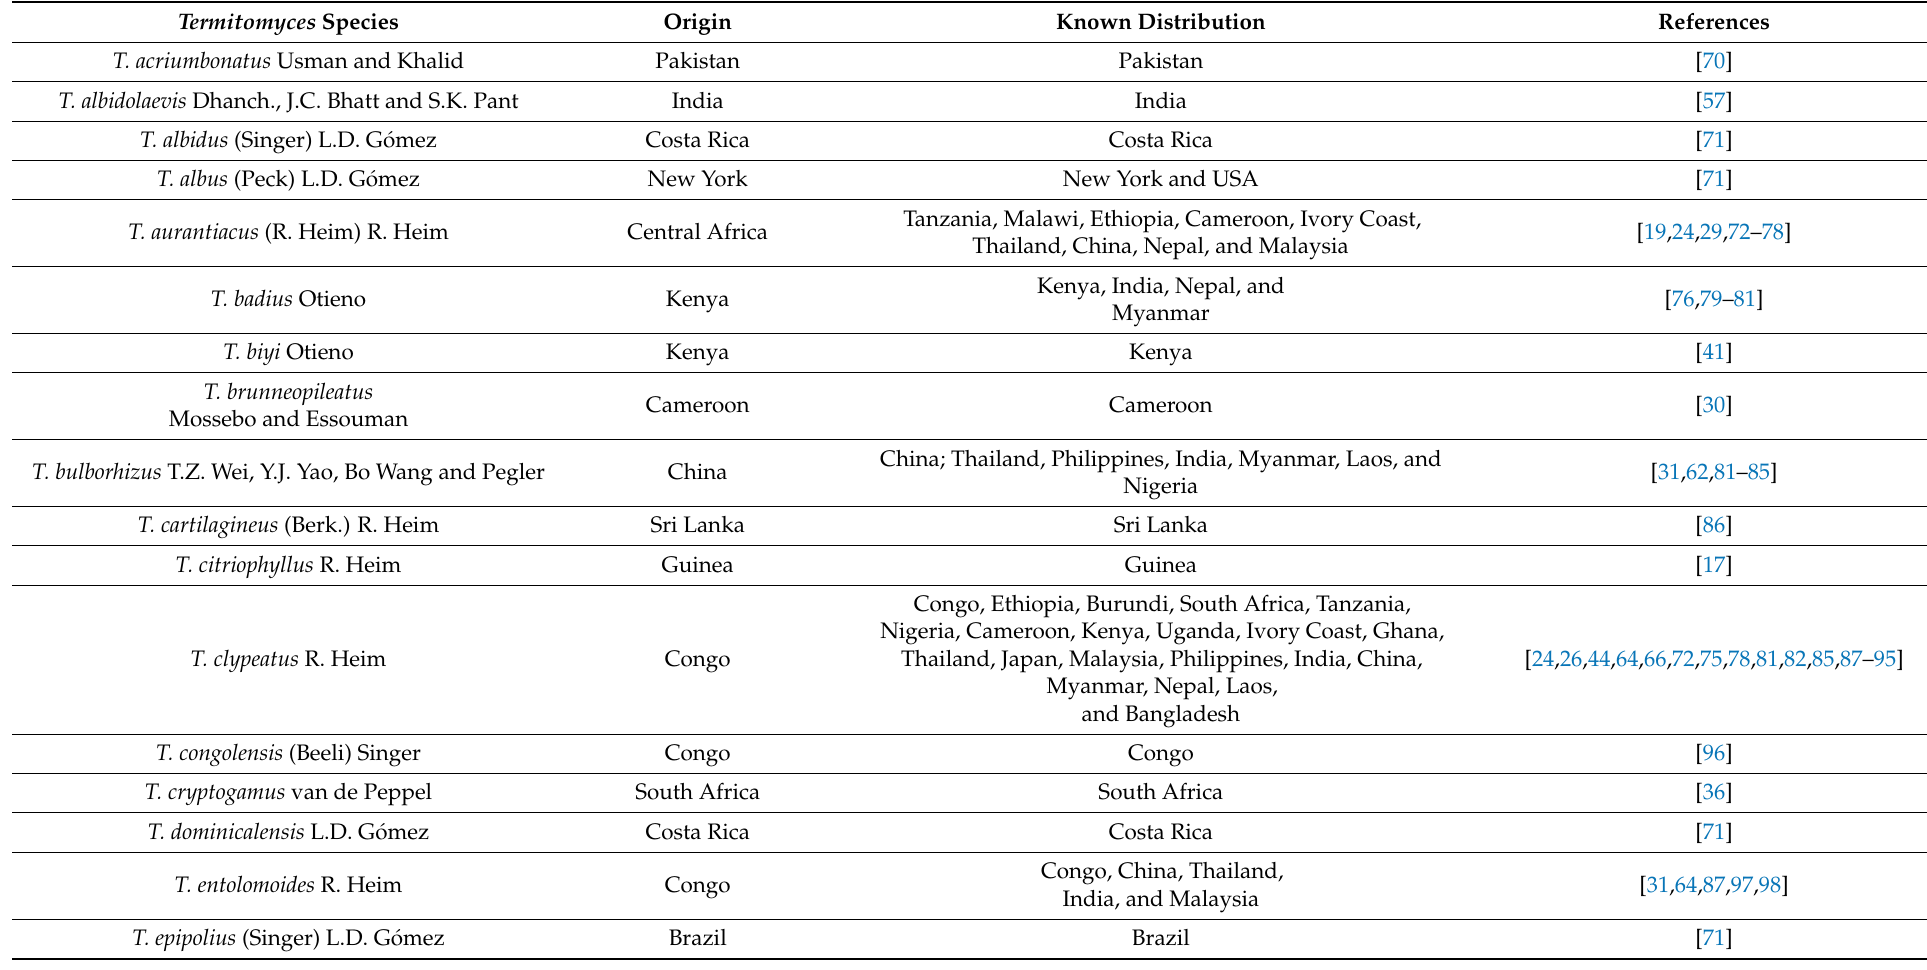
Table 1. List of Termitomyces species, origin, and their known